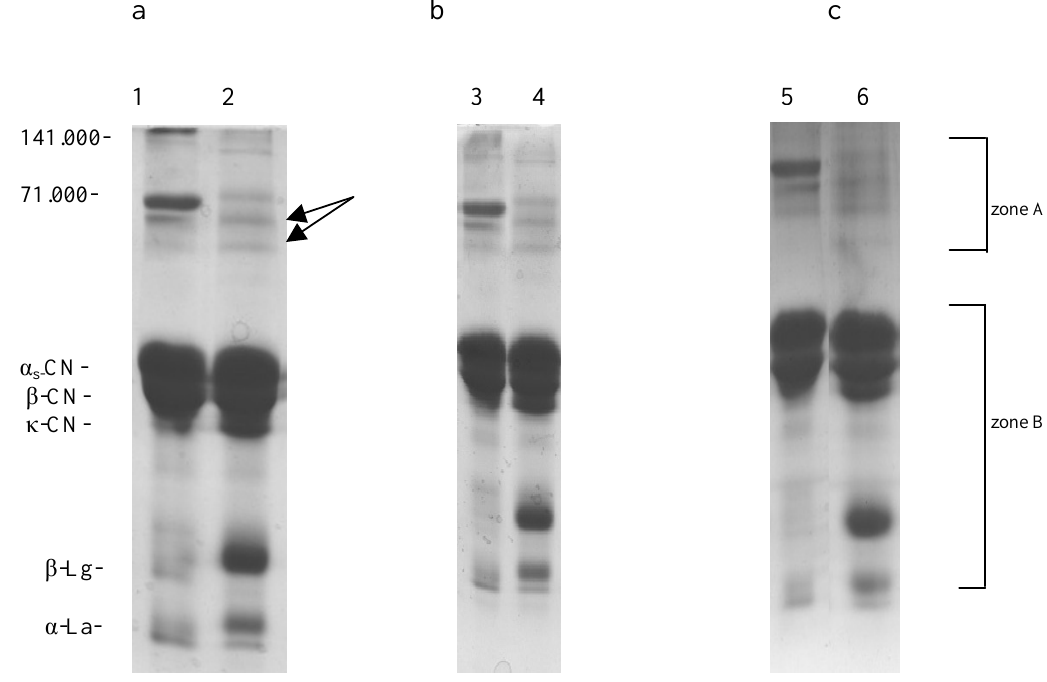
Figure 3 : The SDS-electrophoretic analysis of the heat-treated samples. a. The sample treated at 75°C (1. without and 2.with 2-mercaptoethanol); b. The sample treated at 85°C (3. without and 4.with 2- mercaptoethanol); c. The sample treated at 90 °C (5. without and 6. with 2-mercaptoethanol). The arrows indicate soluble 64 kDa and 57 kDa